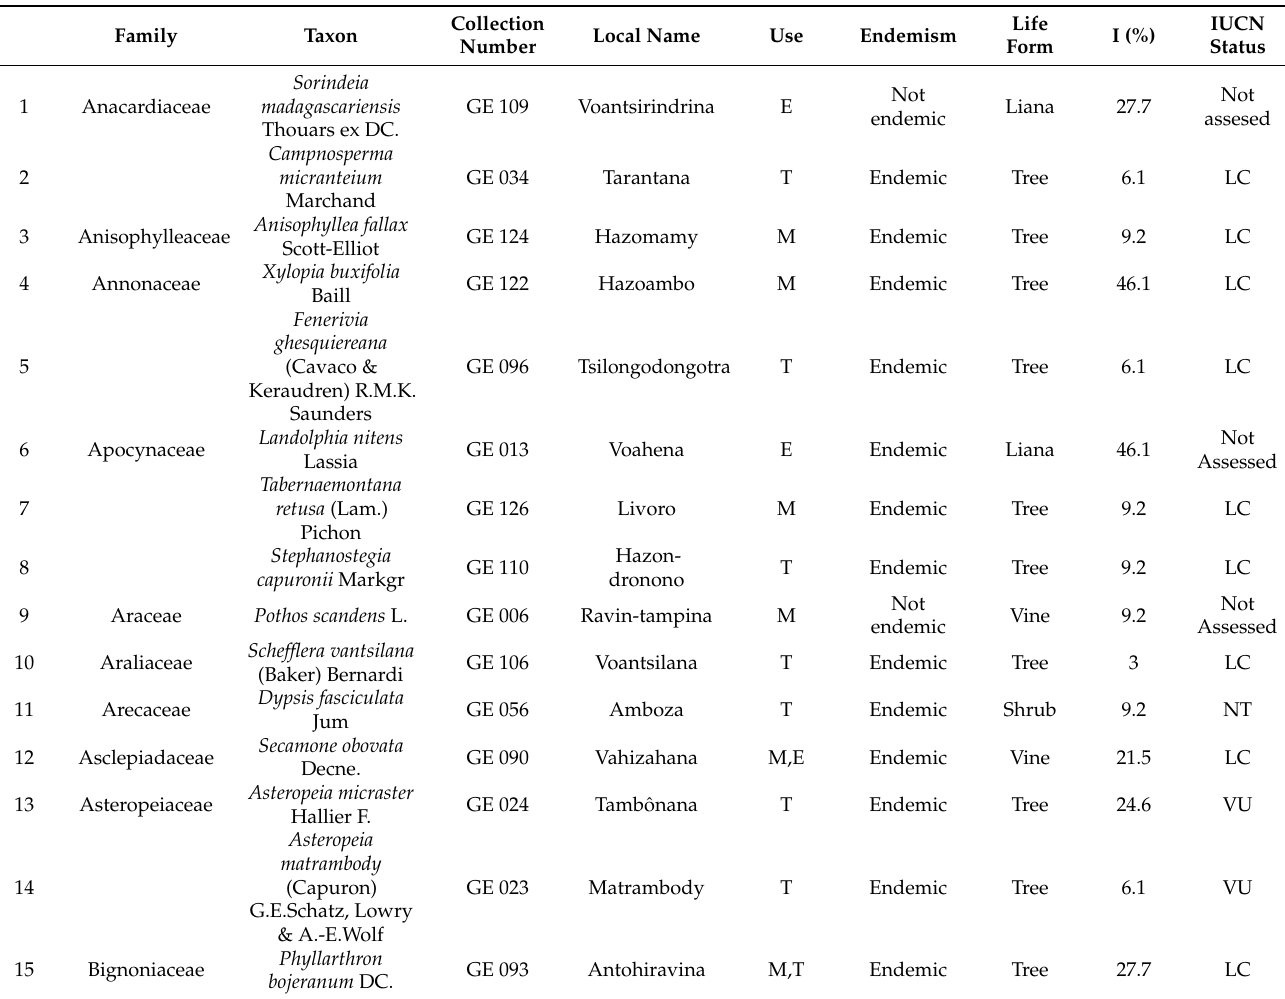
Figure 2. Graphic representation of the utilization of the plants. Table 2. List of useful plants of Tampolo forest (Fenoarivo Atsinanana, Madagascar) with their Use Index {I (%)}. M: Medicinal; T: Timber; E: Edible.